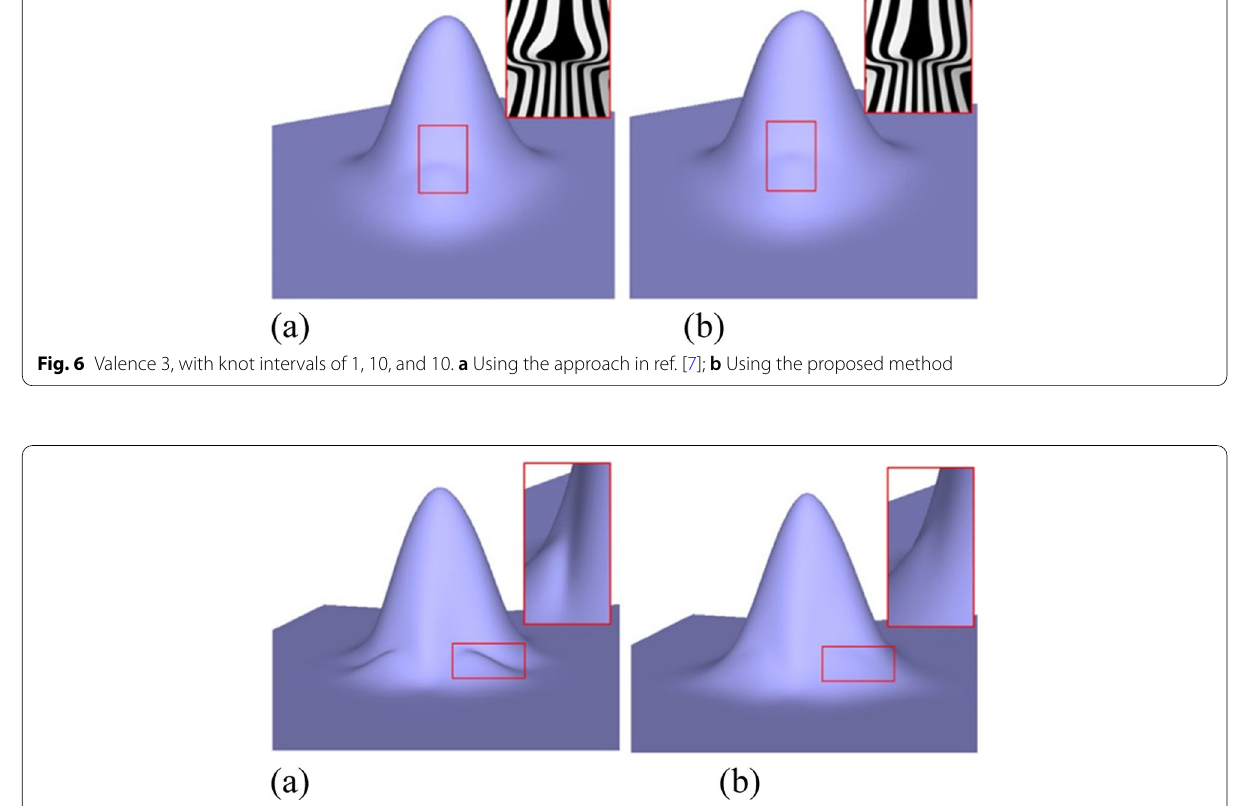
Fig. 7 Valence 5, with knot intervals of 1, 1, 10,000, 10,000, and 10,000. a Using the approach in ref. [7]; b Using the proposed method